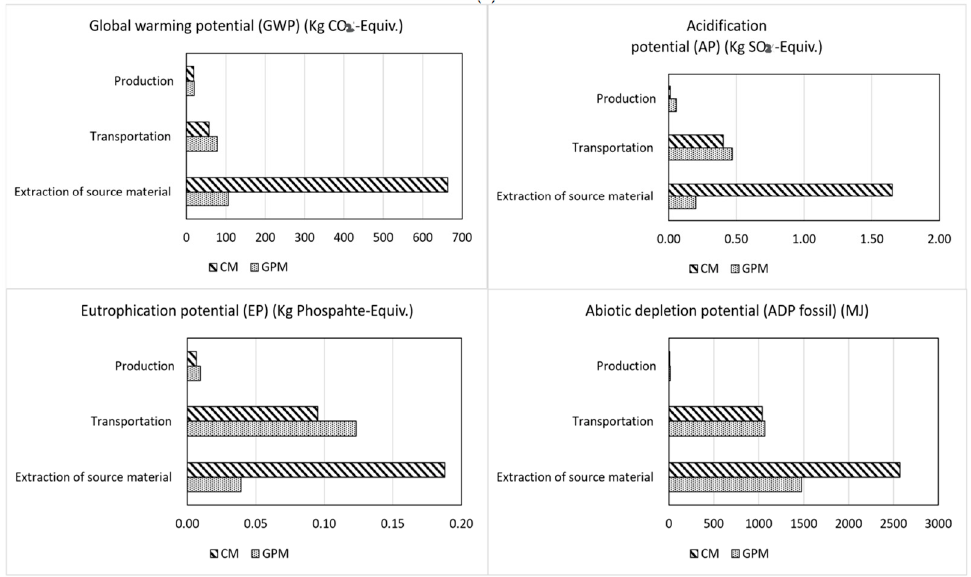
Figure 18. Life cycle assessment for geopolymer and OPC mortar [147].